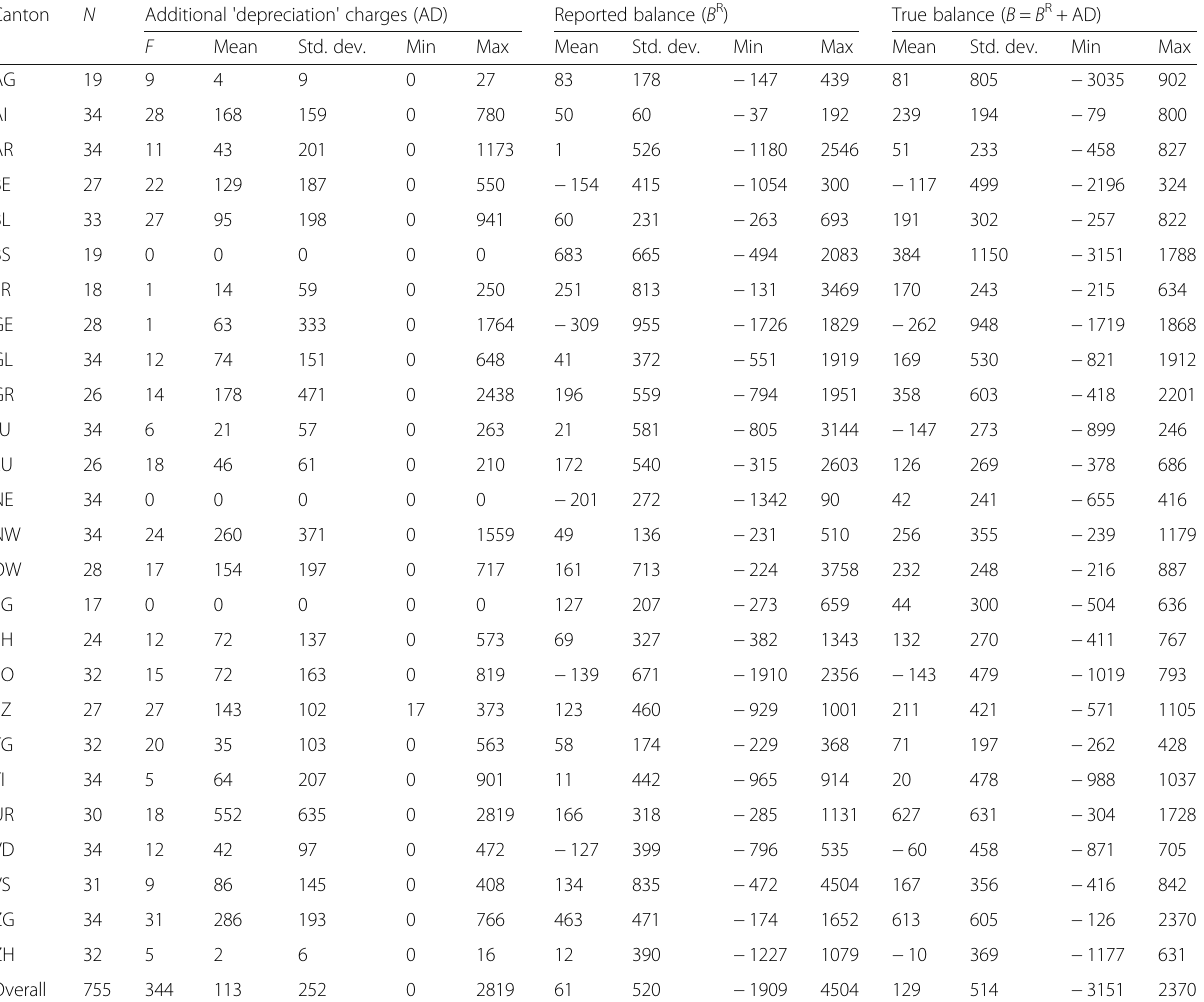
Table 1 Additional 'depreciation' charges, reported and true balance in real Swiss francs per capita — summary statistics per canton (1980 – 2012) Canton